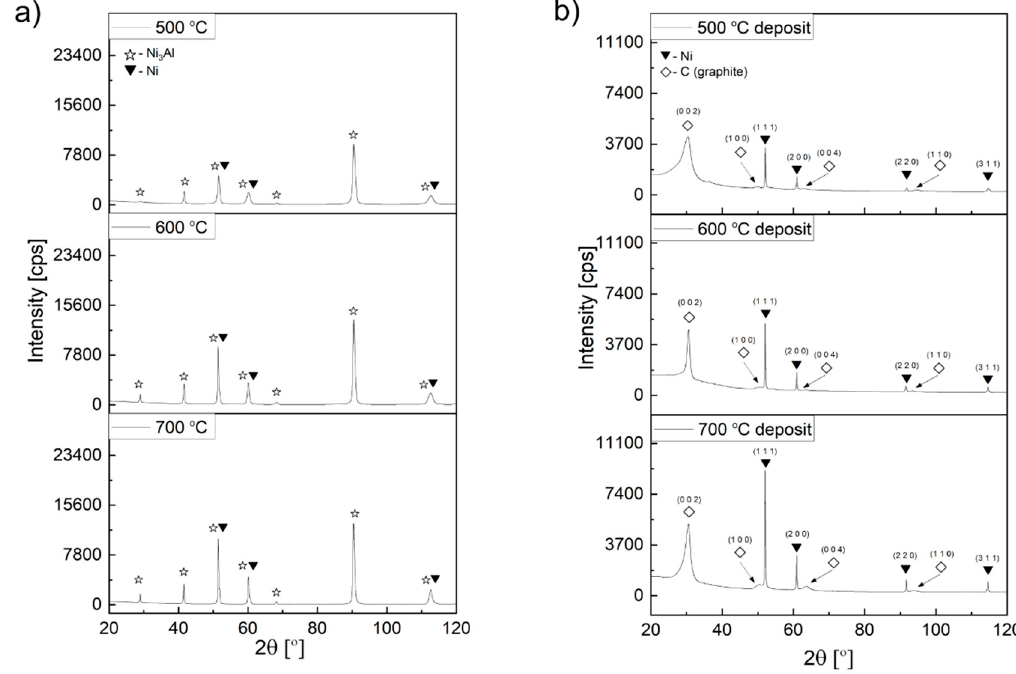
Figure 12. XRD profile obtained after ethanol decomposition without water vapour addition (mixture #1) from: ( a ) Ni 3 Al foils surface with carbon deposit; ( b ) deposit mechanically scrapped from the Ni 3 Al foils’ surface.